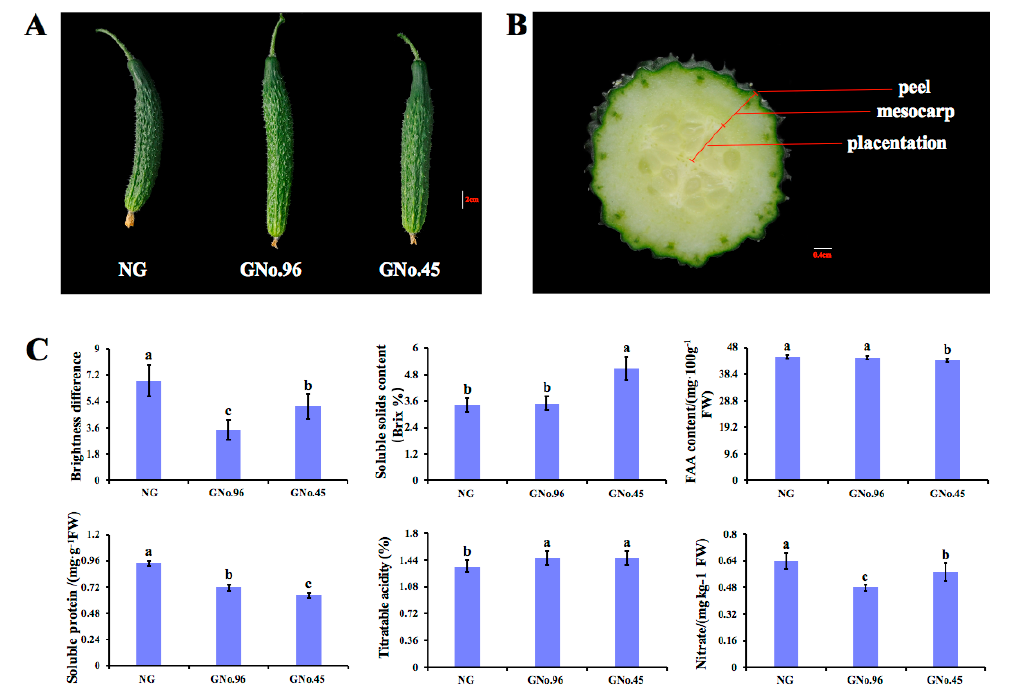
Figure 2. The phenotype and physiological quality of the cucumber fruit in the non-grafted plants, plants grafted onto the rootstocks of No.45 and No.96. ( A ) Phenotype of fruit in non-grafter plants (NG), GNo.96, and GNo.45. ( B ) Peel, mesocarp, and placentation of cucumber fruit. ( C ) Wax power, soluble solids content (SSC), free amino acid (FAA) content, soluble protein content, nitrate content, and titratable acidity in cucumber fruit.